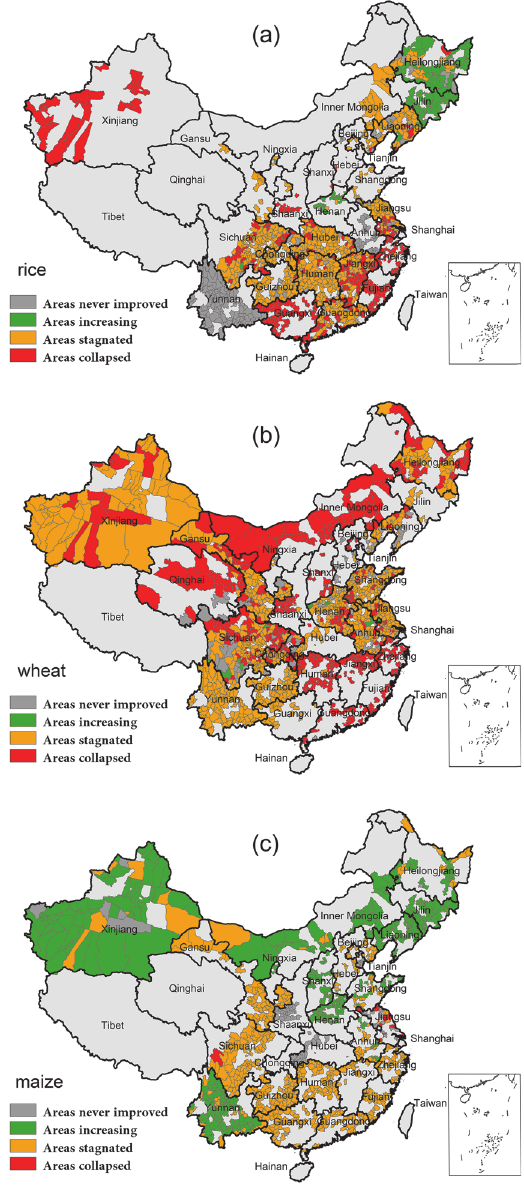
Fig 3. Pattern of the planted area trends for main cereals. At each county where rice (a), wheat (b) and maize (c) crop-growing area were tracked, area trends were divided into four types and employed the same color